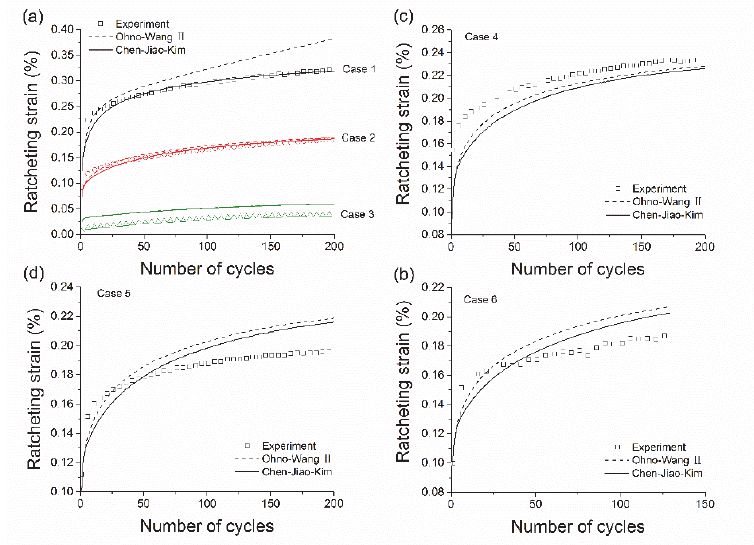
Figure 6: Ratcheting strain predicted by the O-W and the C-J-K models, (a) cases 1-3 under constant axial stress, (b) case 4 under linear path, (c) case 5 under rhombic path, (d) case 6 under circular